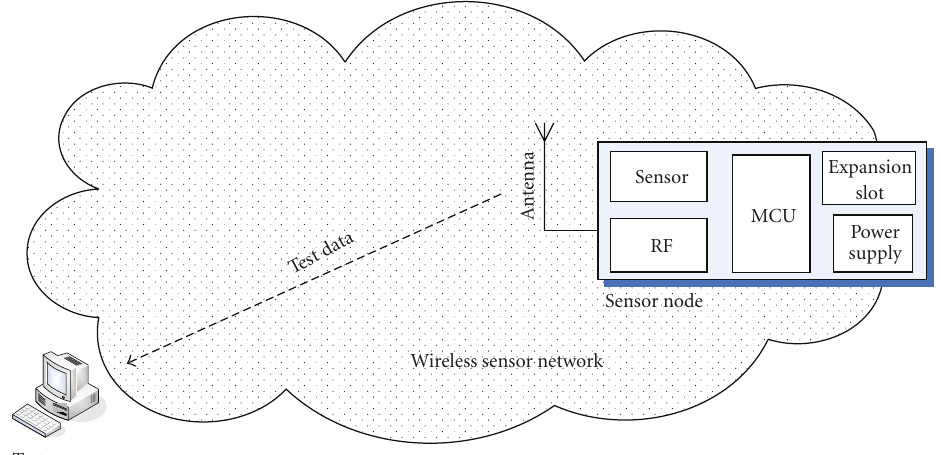
Figure 2: Gathering test data via wireless sensor network itself.